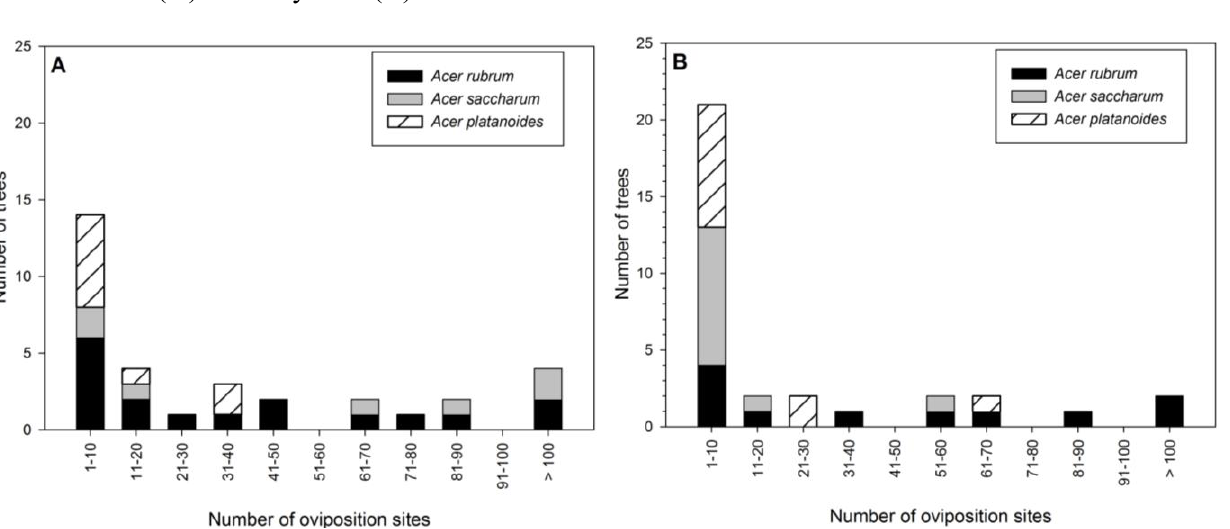
Figure 3. Number of Asian longhorned beetle oviposition pits per tree by Acer species in Delaval ( A ) and Boylston ( B ).